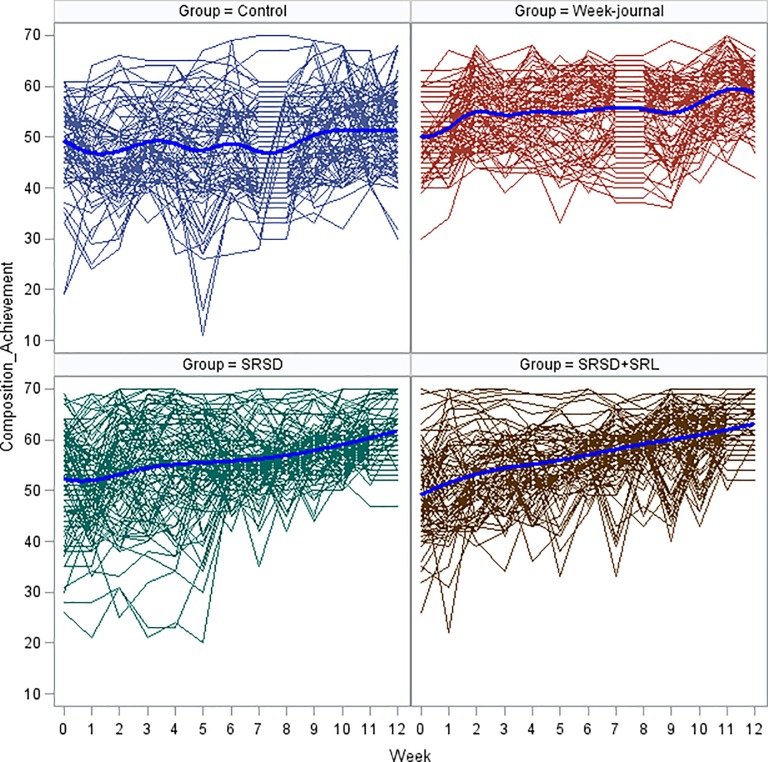
Spaghetti plot of observed data for each participant during the period under study and means (solid line) of the different treatment groups.